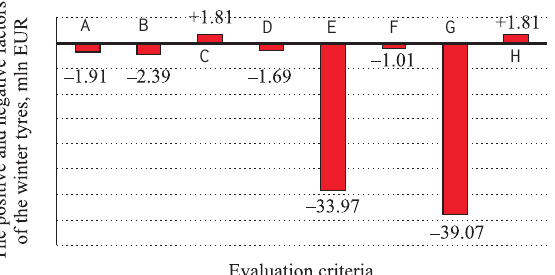
Fig. 9. Economic evaluation of winter tyres (studded and non- studded) (A – additional costs for the drivers due to studded tyres; B – additional costs for the drivers due to non-studded tyres; C – damage due to road accidents; D – eff ect of tyres on fuel costs; E – eff ect of studded tyres on the initiation of particulate matter; F – damage due to tyre-generated noise; G – eff ect of tyres on pavement marking; H – total